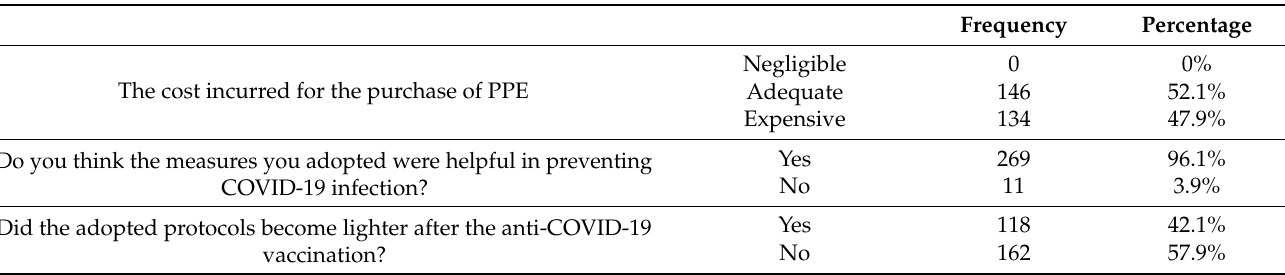
Table 3. Costs incurred for all protective devices and measures and their help in preventing